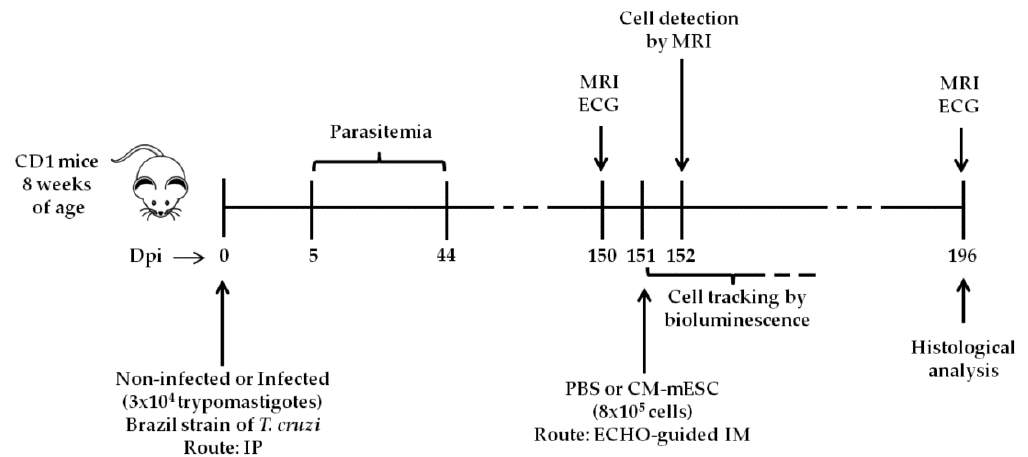
Figure 1. Schematic illustration of the experimental design. CM-mESC—cardiomyocytes derived from mouse embryonic stem cells, ECG—electrocardiogram, ECHO—echocardiogram, Dpi—days post-infection, IM—intramyocardial, IP—intraperitoneal, MRI—magnetic resonance imaging.